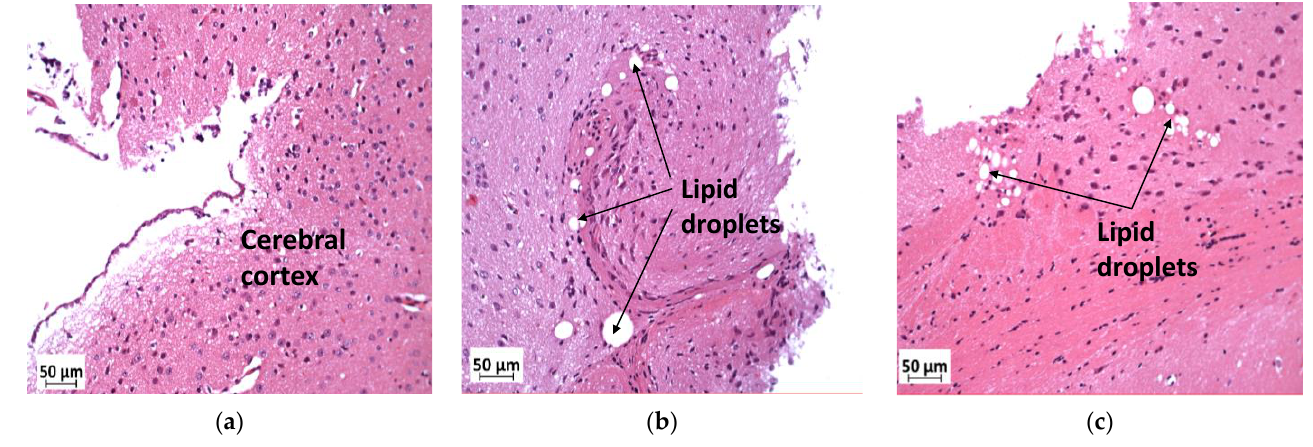
Figure 8. Effect of slc7a8 deletion on lipid droplet accumulation in brain tissue. H&E-stained sections of brain tissue showed lipid droplets in the cerebral cortices of KOHFD ( b ) and WTHFD ( c ) that were not seen in that of WTCD ( a ). Magnification = 20×. Scale bar = 50 µm .